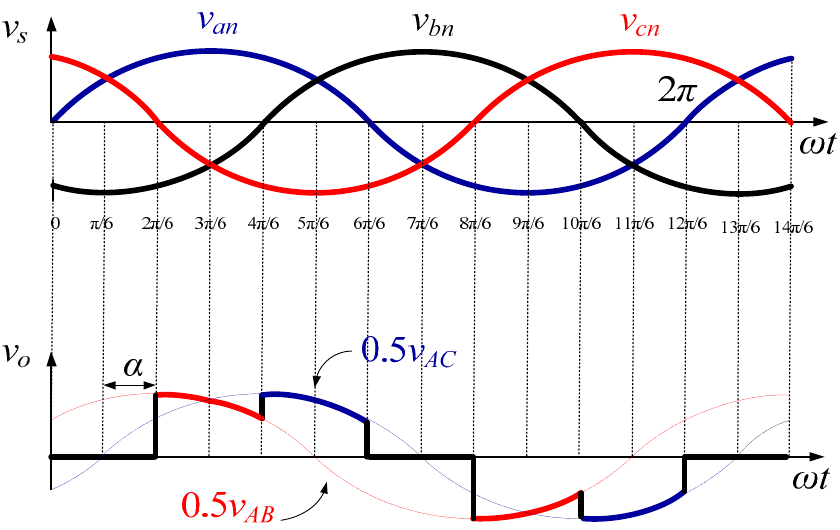
Figure 6. Output RMS voltage control of three-phase AC voltage controller.